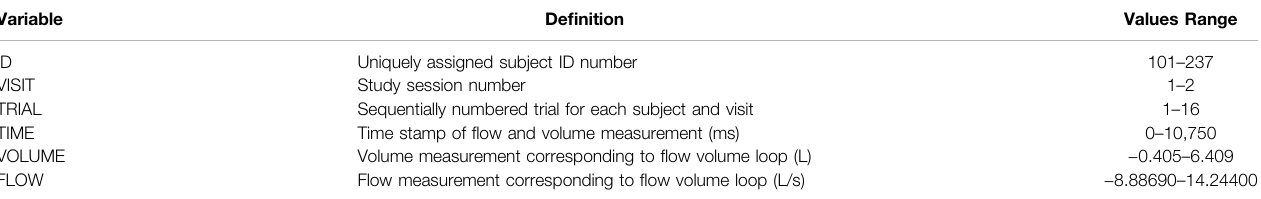
TABLE 1 | Main dataset variables summary.